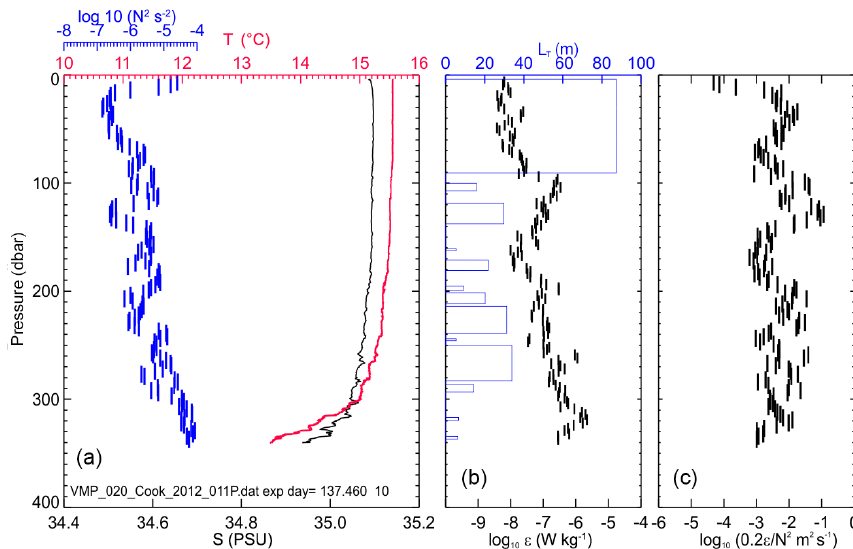
Figure 8. Profile B from day 137, 2012, showing (a) temperature, salinity and buoyancy frequency squared ( N 2 ); (b) L T and ε ; and (c) proxy for vertical diffusivity 0.2 ε/N 2 . Note the profile extends over the full depth of the water